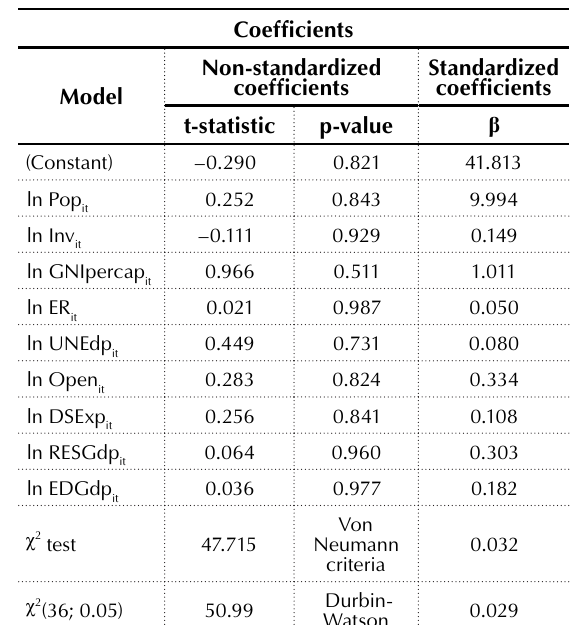
Table 3. T-test and estimation of